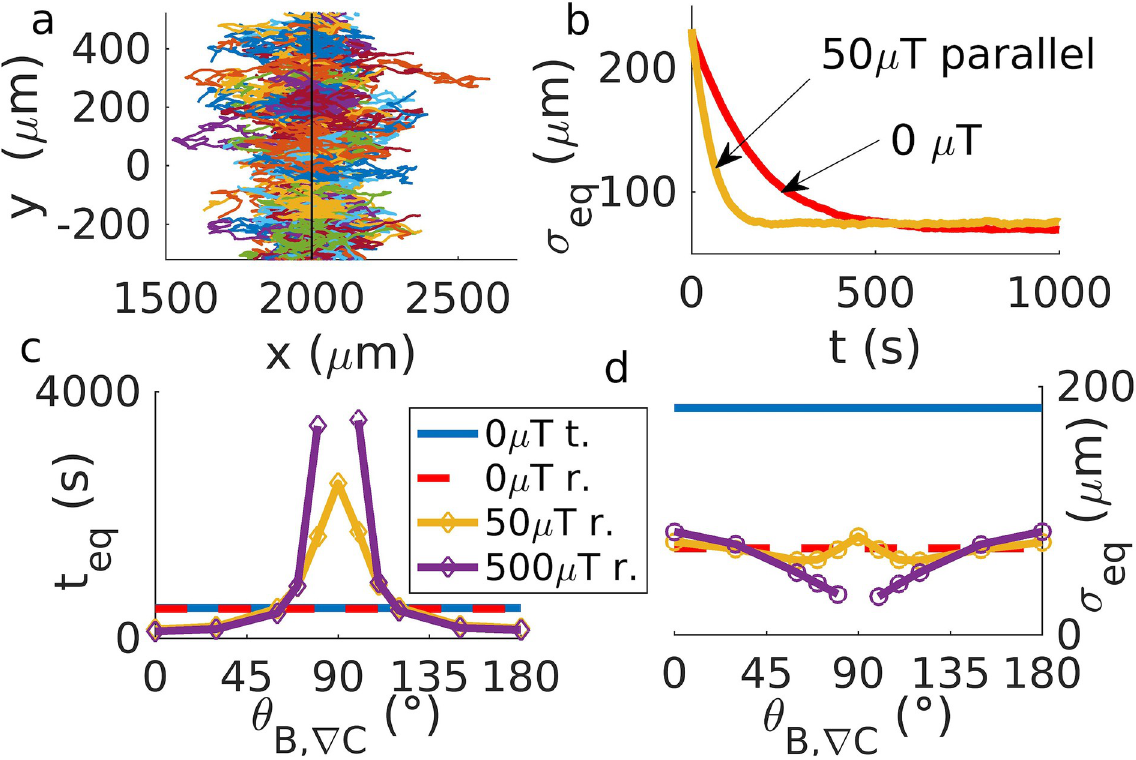
Fig 6. Band formation in constant concentration gradients. a) 100 example trajectories are shown for chemotaxis towards a preferred concentration at the position indicated by the black line. The bacteria concentrate there and form a band. b) Width of the band as a function of time, estimated by the standard deviation of the position of the bacteria in the direction of the gradient, σ eq , for scenarios with and without a magnetic field parallel to the gradient. c) Equilibration time t eq ( i.e . time at which the band stop growing in amplitude and reaches steady state) and d) width of the band at equilibrium, plotted as a function of the angle θ B , r C between the gradient and the magnetic field, for tumble (t.) and reverse (r.) with different intensities of the magnetic field. While run-and-reverse behavior results in band formation for almost any magnetic condition, run-and-tumble bacteria only forma a band without magnetic